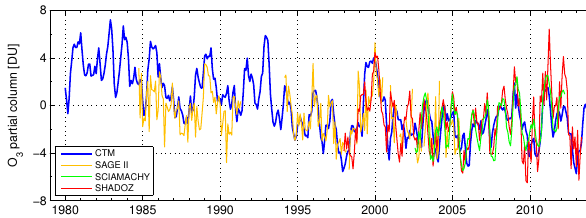
Figure 2. Observed and simulated tropical (20 ◦ N–20 ◦ S) LS O 3 partial columns (17–21km). Anomalies are deviations from the modelled 1980–2013